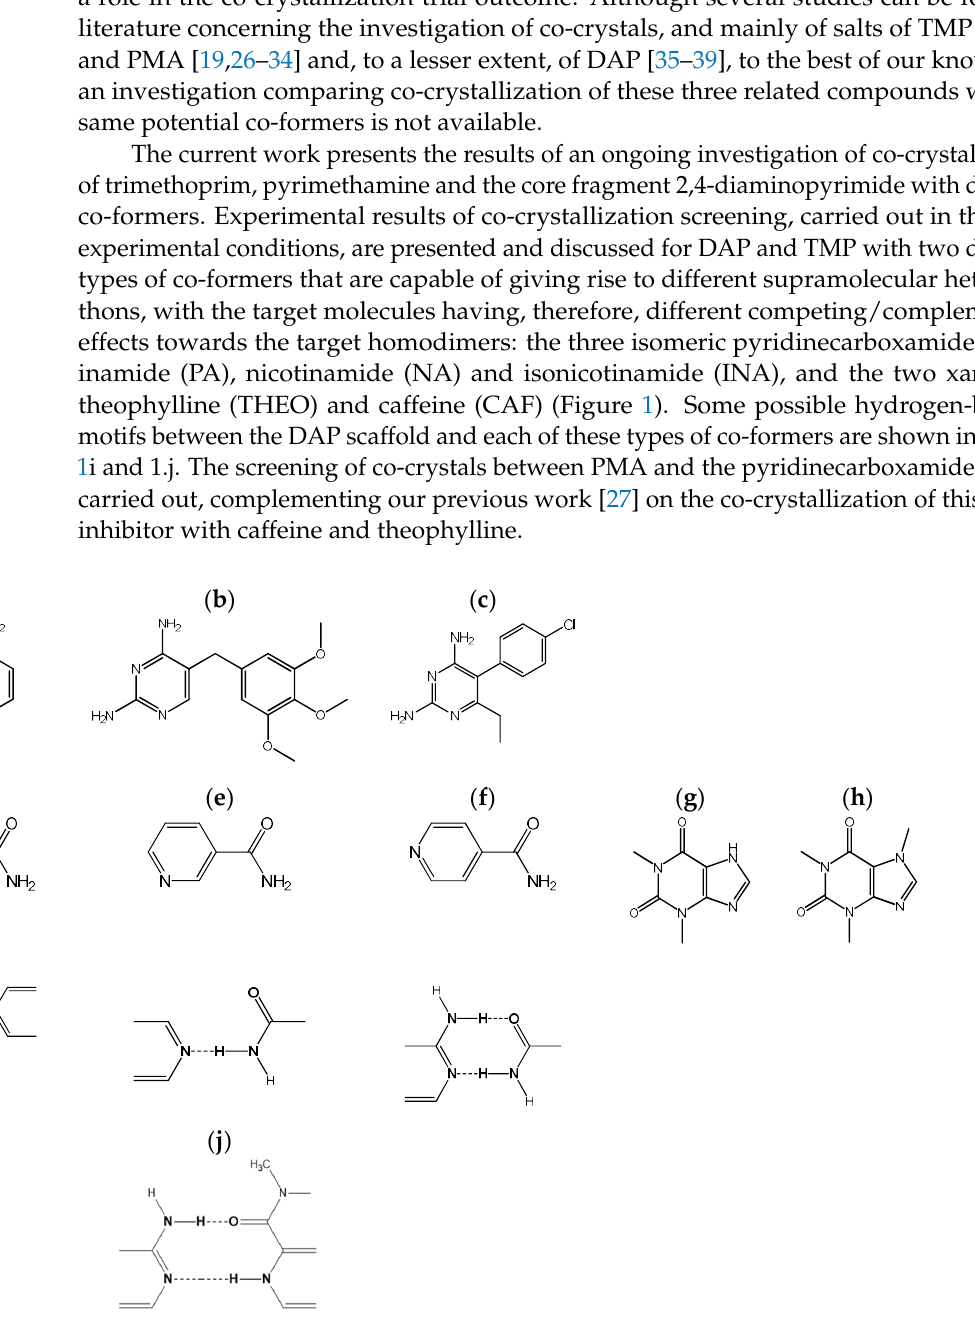
Figure 1. Molecular structures: ( a ) 2,4-diaminopyrimidine, ( b ) trimethoprim, ( c ) pyrimethamine, ( d ) picolinamide, ( e ) nicotinamide, ( f ) isonicotinamide, ( g ) theophylline, ( h ) caffeine. ( i ) Illustration of possible association points between the DAP scaffold and pyridinecarboxamides, ( j ) Illustration of a possible association between the DAP scaffold and theophylline.